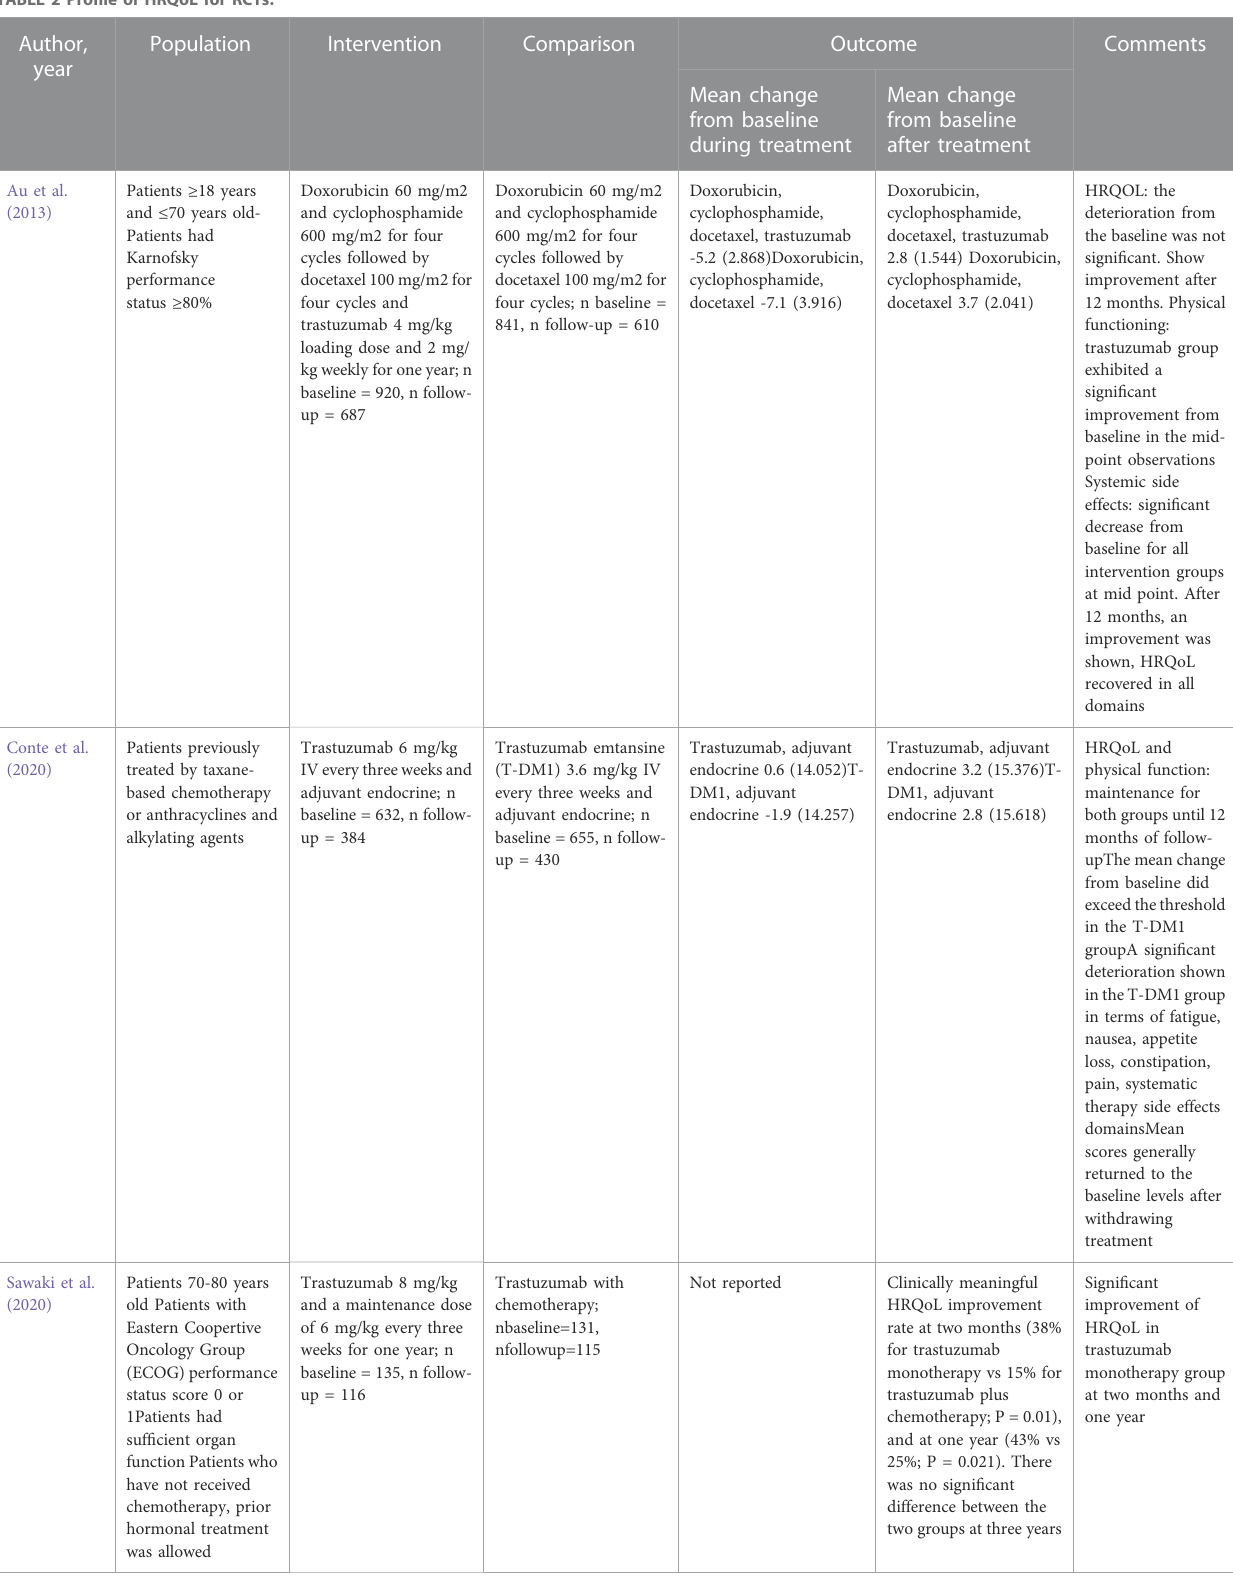
TABLE 2 Pro fi le of HRQoL for